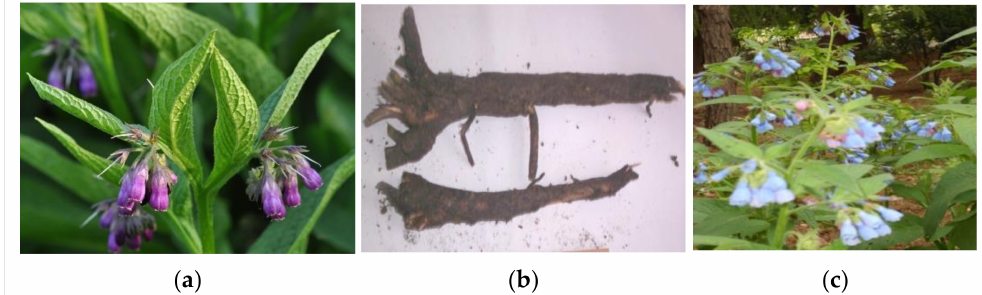
Figure 1. ( a ) Comfrey ( S. officinale ) plant leaves and flower. This file is licensed under the Creative